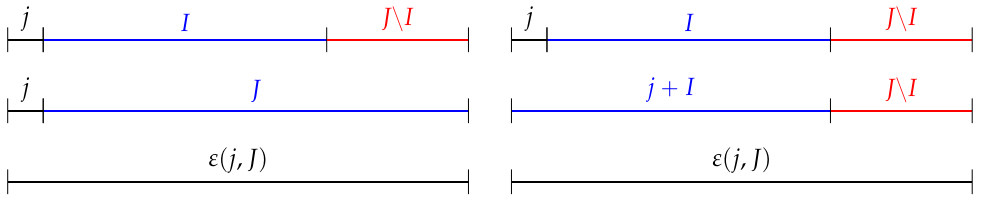
Figure 1. Visual aid for the identity among permutations in Equation